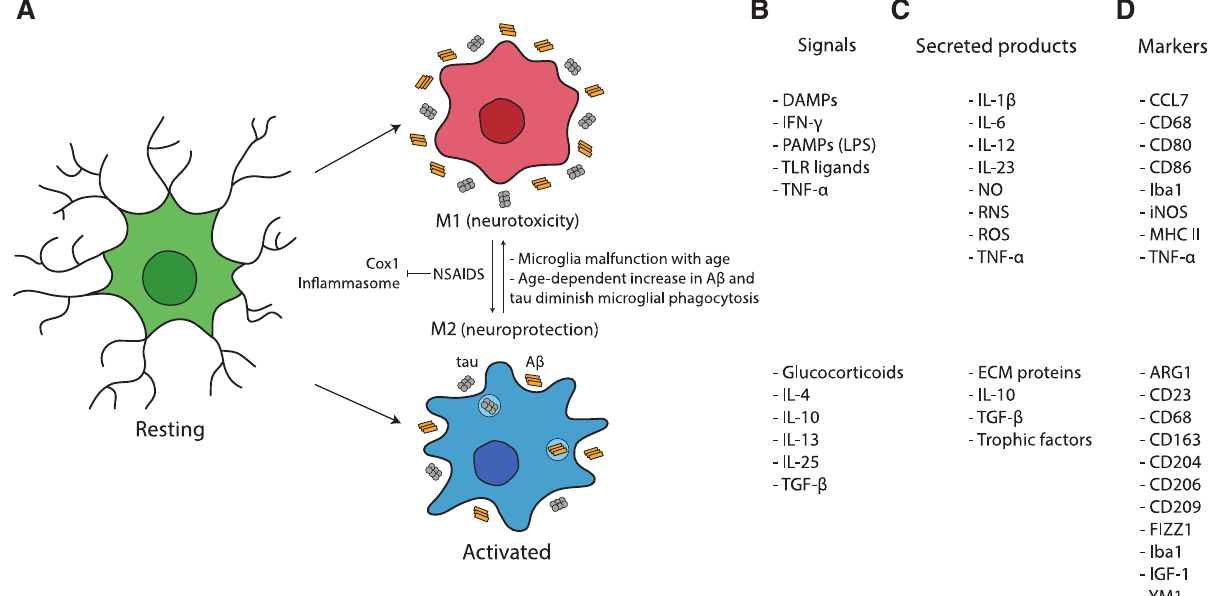
Figure 1: Diagram of polarization states of